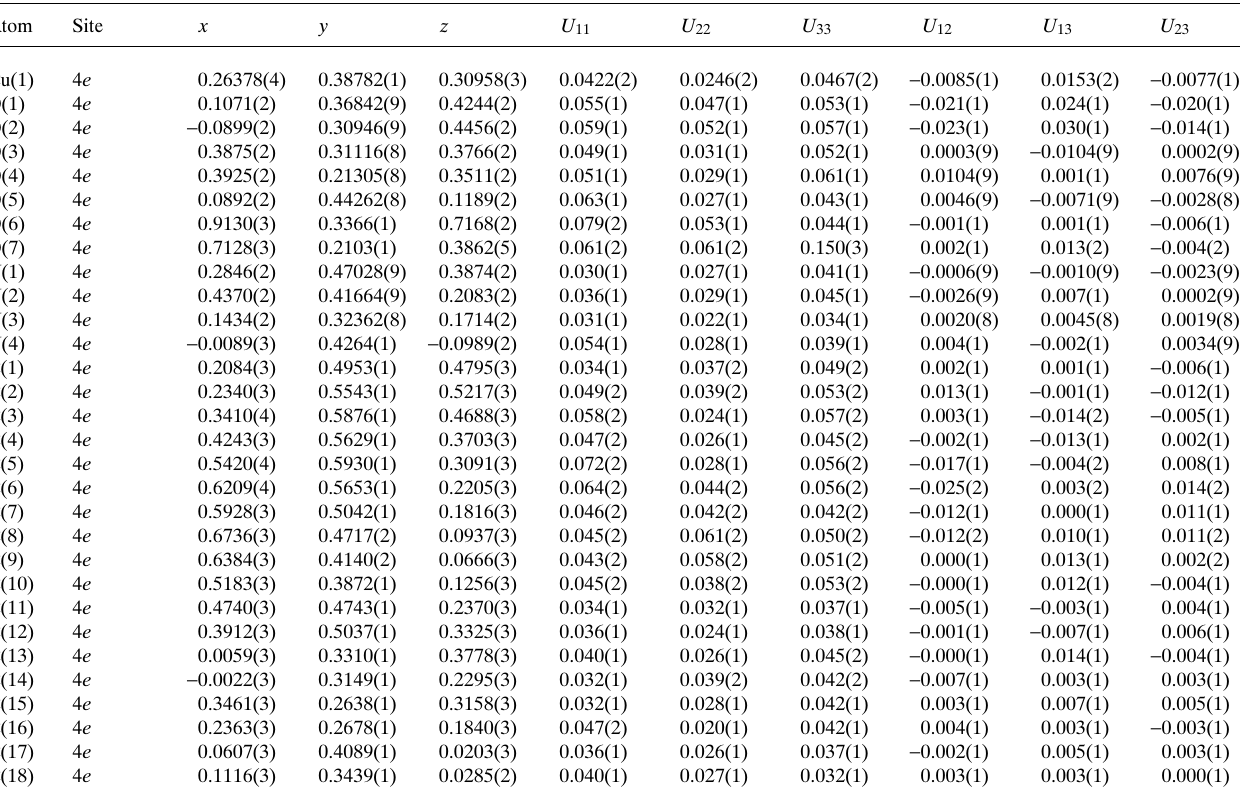
Table 3. Atomic coordinates and displacement parameters (in Å 2 ) .